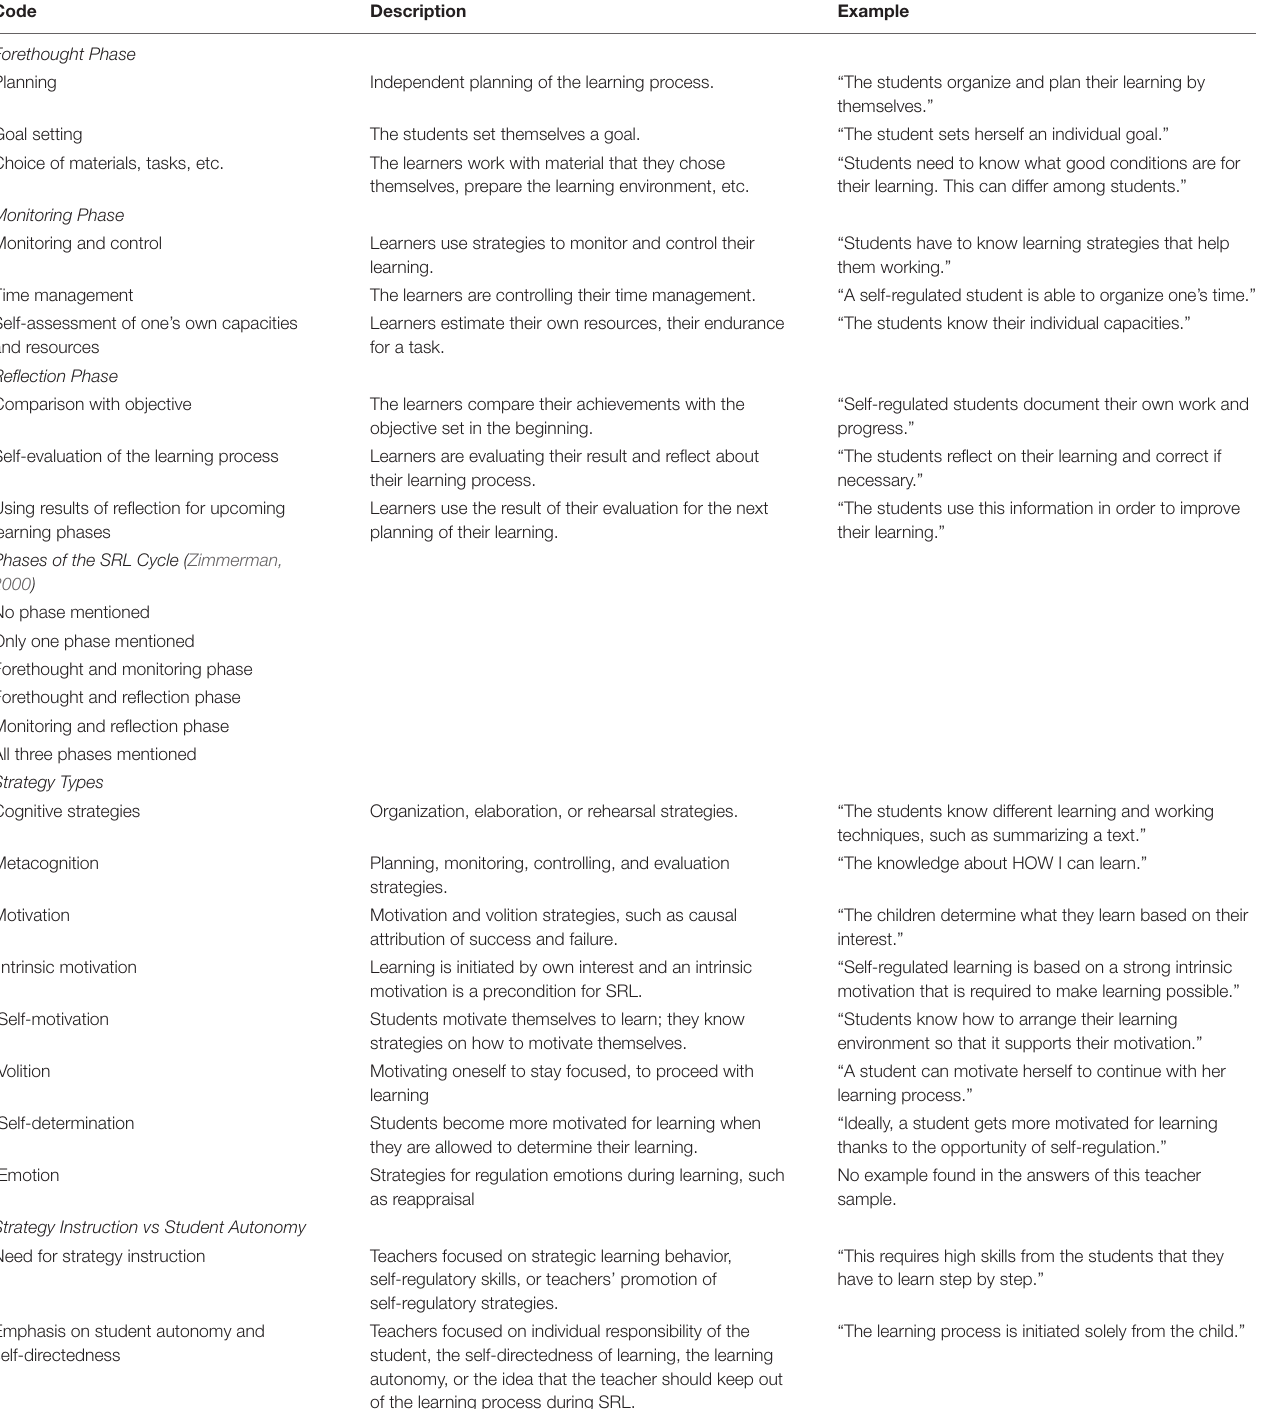
TABLE 1 | Coding manual for teachers’ conceptualization of SRL with examples per code. Code Description Example